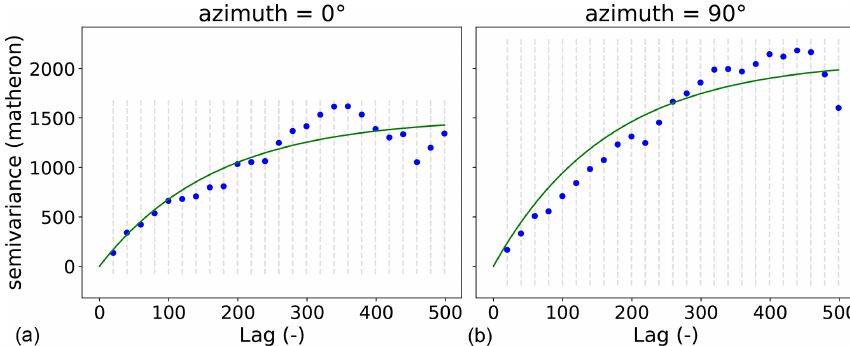
Figure 5. Two directional variograms calculated for the pancake dataset. Both variograms use the same parameters as the instance used to produce Fig. 2. In addition, the direction is taken into account. The two variograms shown differ only in the azimuth used, which is 0 ◦ (a) and 90 ◦ (b) .